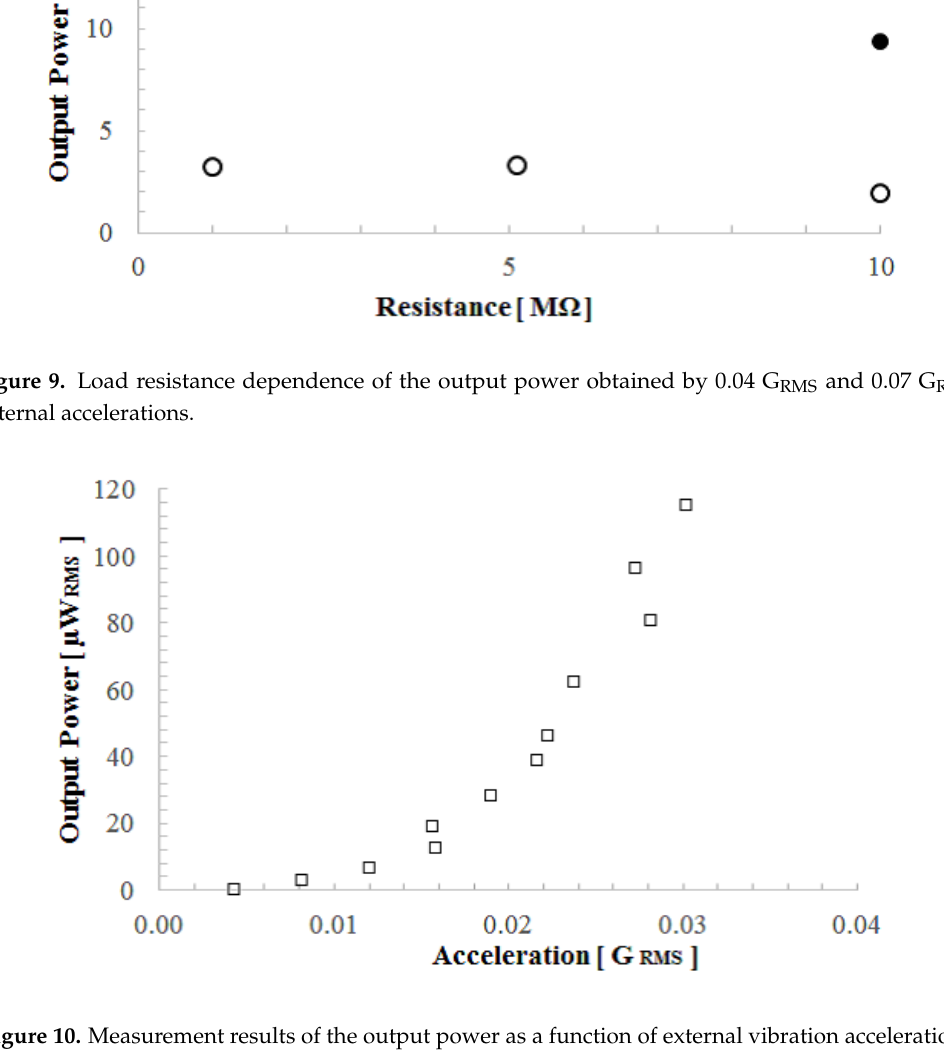
Figure 10. Measurement results of the output power as a function of external vibration